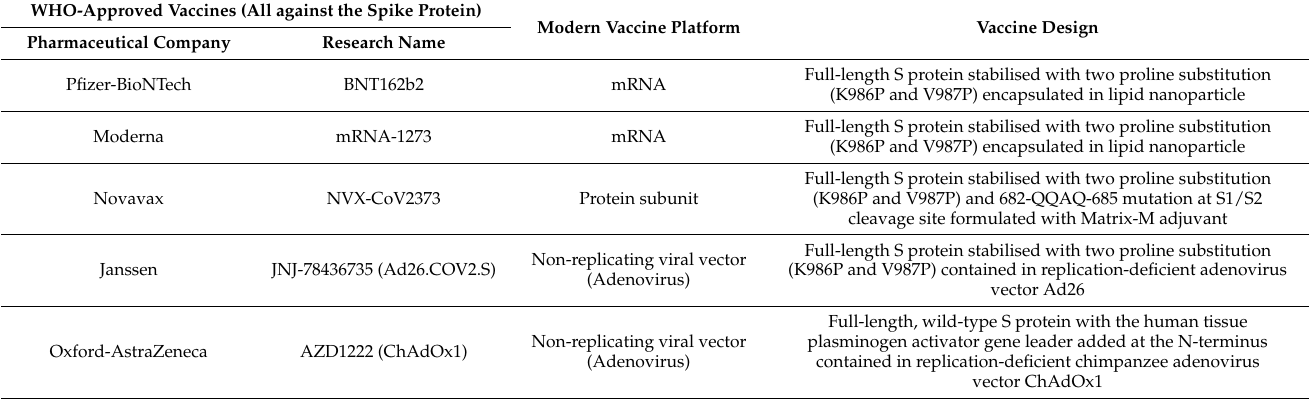
Table 1. Summary of the vaccine design of the WHO-approved COVID-19 modern vaccines. WHO-Approved Vaccines (All against the Spike Protein) Modern Vaccine Platform Vaccine Design Pharmaceutical